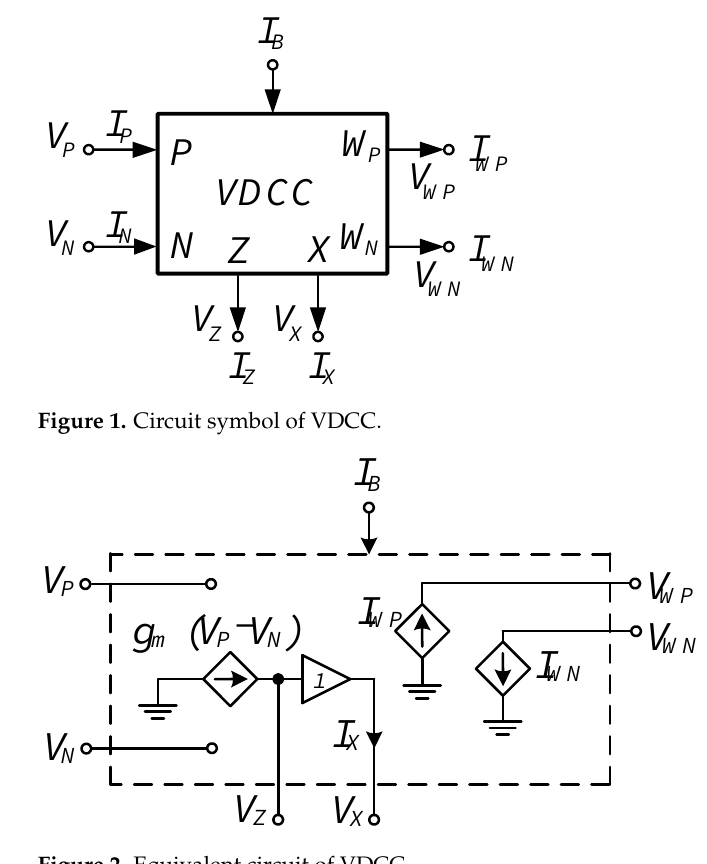
Figure 2. Equivalent circuit of VDCC.